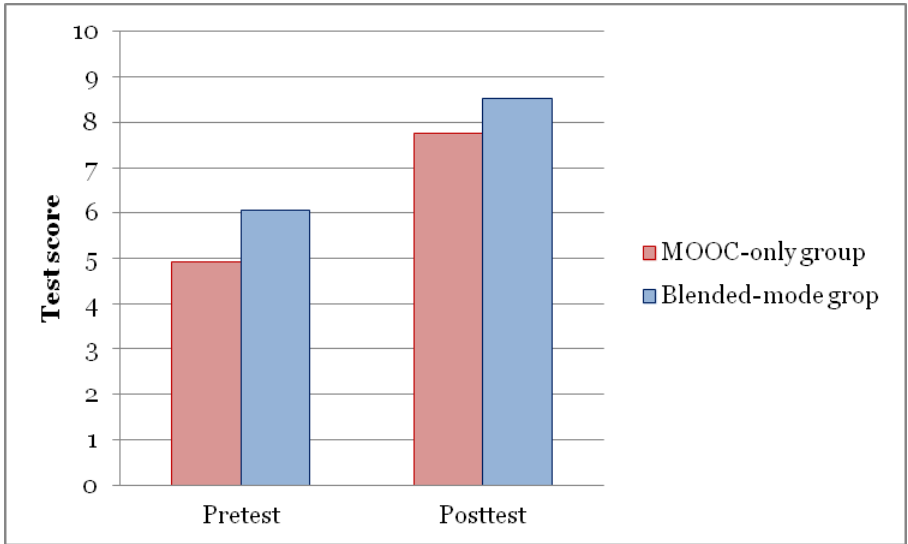
Figure 1. Students’ performance in pretest and